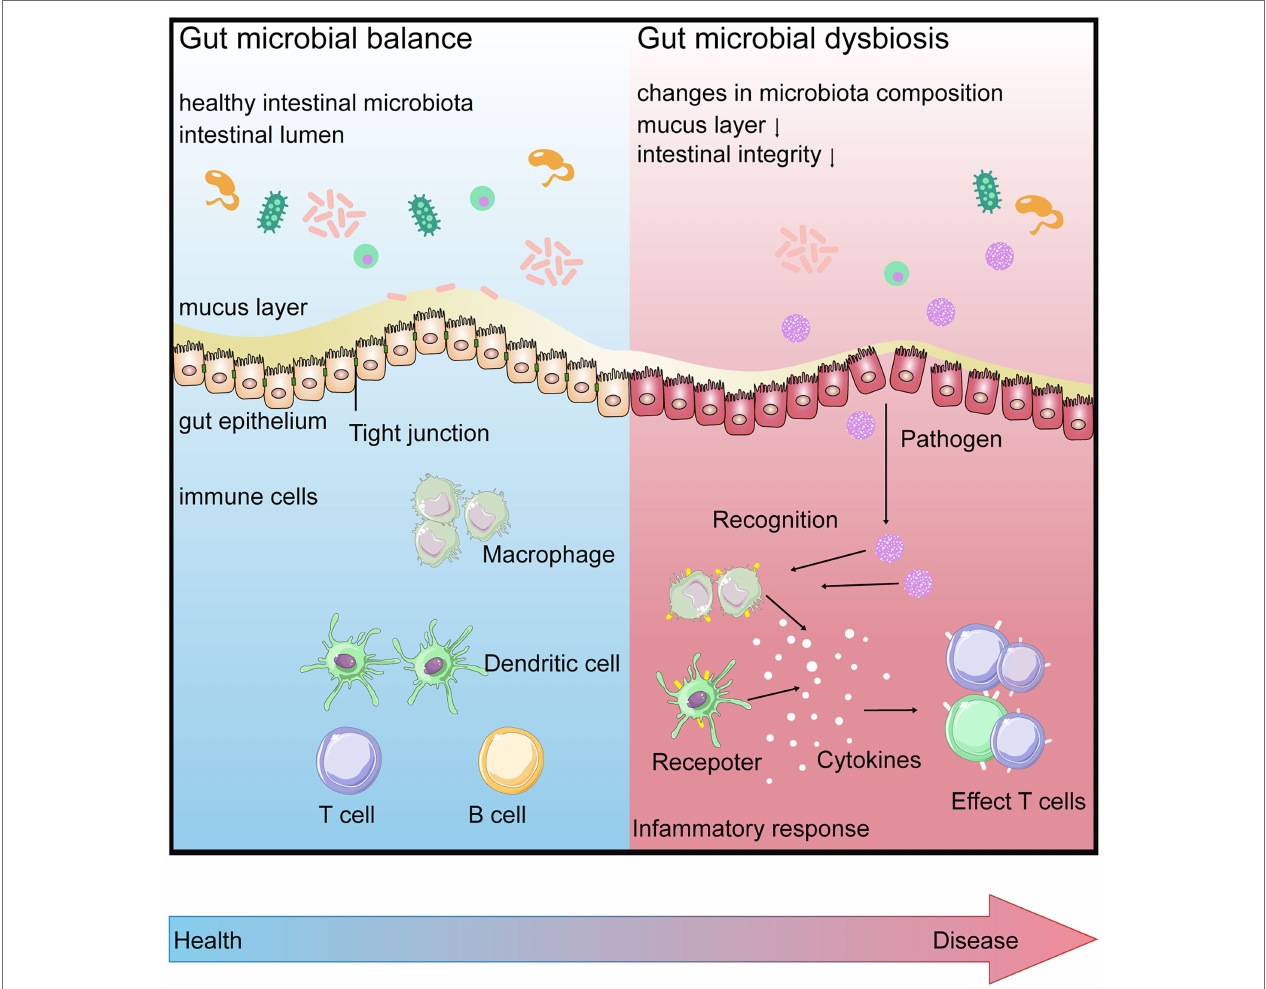
FIGURE 2 | Gut microbial balance (BLUE) vs. gut microbial dysbiosis (RED). When in intestinal homeostasis, gut barrier contributes to surveillance the gut for the entrance of any pathogens. Disruption of the homeostatic relationship between the gut microbiota and gut barrier, the increasing intestinal permeability is involved in further increasing inflammation via gut mucosal immune system, leading to